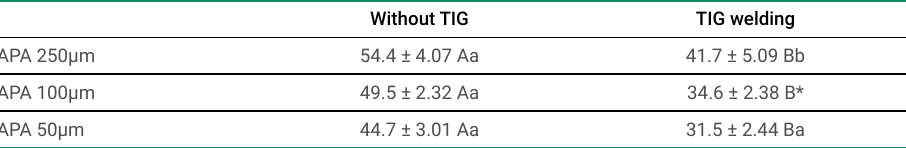
Table 3. Mean (MPa) and Standard Deviation of the flexural